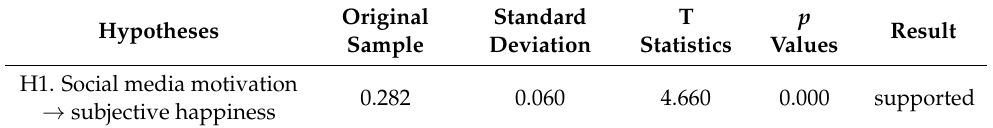
Table 4. Hypotheses testing results.